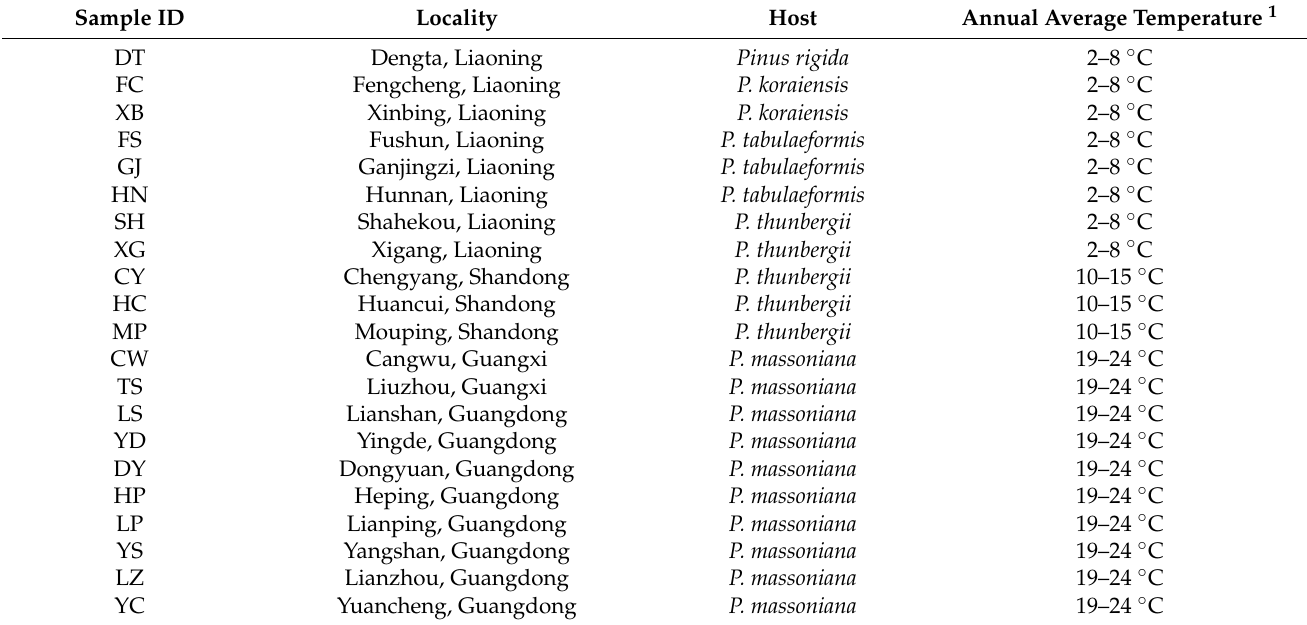
Table 1. Origin of Bursaphelenchus xylophilus strains used in this